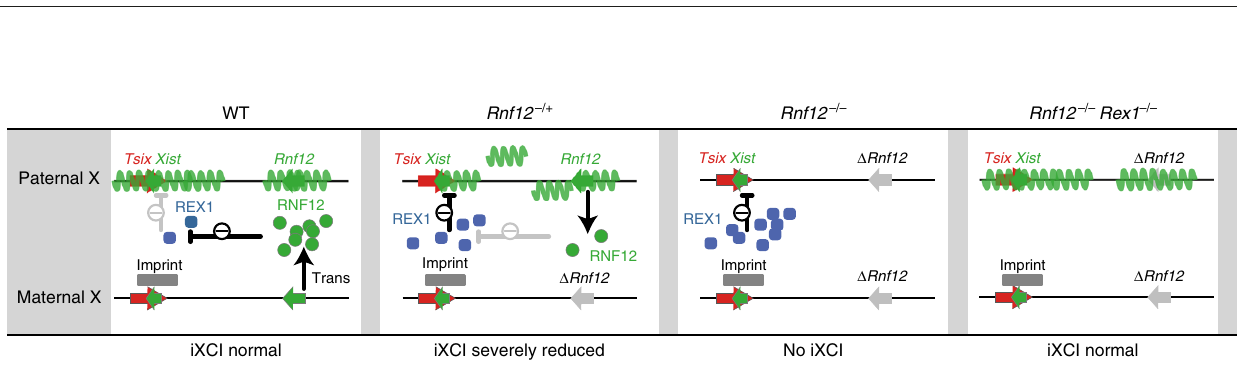
Fig. 5 Rnf12 − / − :Rex1 − / − double knockout mice are viable and have normal iXCI and rXCI. a Sex and genotype distribution from different Rnf12 mutant crossings in an Rex1 -de fi cient background. Number of breedings, number of mice per breeding and total number of mice are indicated. Note that female embryos were born with a maternally transmitted Rnf12 deleted allele in an Rex1 − / − background. No signi fi cant bias in gender or genotype was observed ( χ 2 , p > 0.05). b Representative Z -stack projections of WT, Rnf12 − / − :Rex1 − / − and Rnf12 − /y :Rex1 − /y E4.5 blastocysts immunostained for REX1 (red), H3K27me3 (Xi marker, green), the trophectoderm marker CDX2 (grey) and DNA (DAPI, blue). Scale bars: 20 μ m. WT samples are same control samples as in Fig. 4b. c Xist , G6pdx and Mecp2 allele-speci fi c RNA expression analysis in E11.5 female Rnf12 − / + : Rex1 − / − embryos (E) and corresponding VYSE. d Quanti fi cation of the average allelic Xist (green), G6pdx (blue) and Mecp2 (pink) expression in E11.5 female WT and Rnf12 − / + : Rex1 − / − embryos and VYSE in c . Light/dark colours indicate cas or 129 allelic origin, respectively. WT samples are same control samples as in Fig. 3f. The number of mice analysed is indicated. e Xist , G6pdx and Mecp2 allele-speci fi c RNA expression analyses in heart (H), liver (Li), stomach (St), brain (Br) and lung (Lu) in two Rnf12 − / − : Rex1 − / − 4-week-old female mice. f Quanti fi cation of the average allelic Xist (green), G6pdx (blue) and Mecp2 (pink) expression in WT and Rnf12 − / + : Rex1 − /